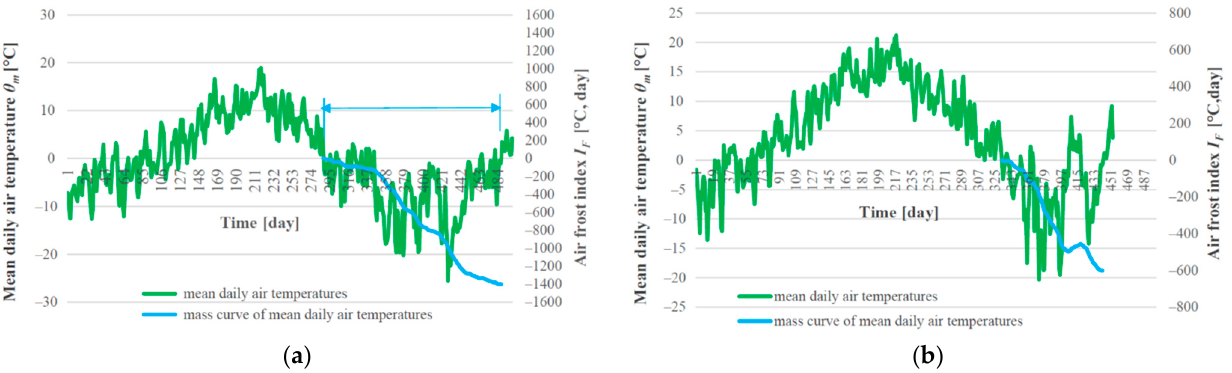
Figure 10. Graphical representation of selected climate characteristics used for numerical modelling air freezing index I F = 1400 °C, day and average annual air temperature θ m = 2 °C ( a ), I F = 600 °C, day air freezing index I F = 1400 ◦ C, day and average annual air temperature θ m = 2 ◦ C ( a ), I F = 600 ◦ C, and θ m = 6 °C ( b ). day and θ m = 6 ◦ C ( b